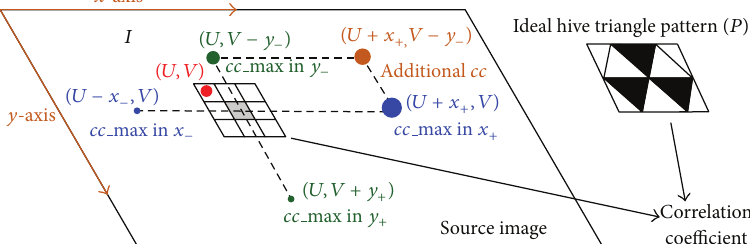
Figure 5: Correct location of pattern is estimated from source image and ideal hive triangle pattern with digital image correlation coefficient. Threelargestcircles(green,blue,andorange)indicatethreelargestcorrelationcoefficients;thehighestcorrelationcoefficientisin 𝑥 + direction.